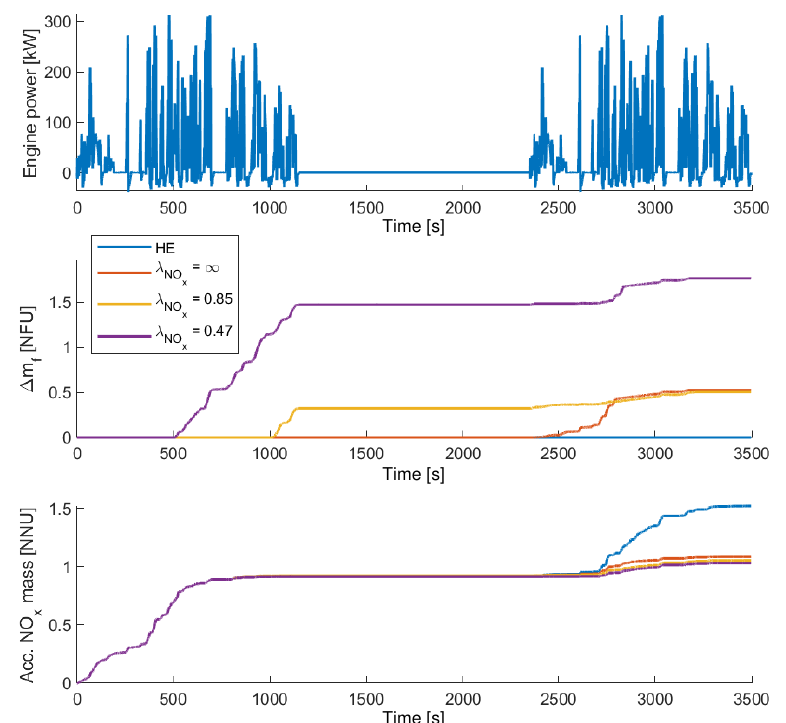
Figure 7. Results from simulations of the single-event cycle for different λ NO is also the result from using the high-efficiency (HE) mode after the cold start is over, this simulation is used as a reference when calculating ∆ m f